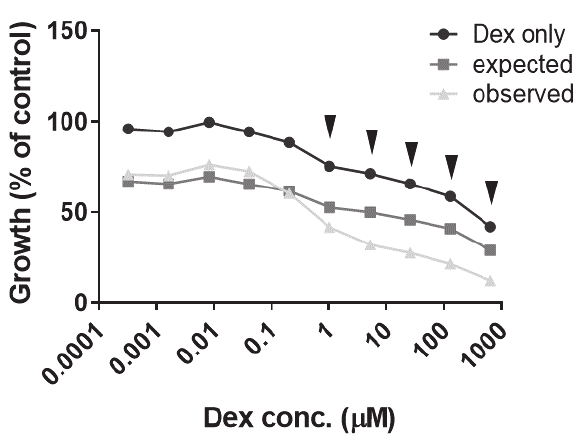
Figure A4. Dose–response curves obtained for CEM / R30dm after 72h incubation with 1 nM Plad-B combined with a dilution range of Dex. The expected e ff ect was calculated (by multiplying the e ff ects of both single agents alone) and plotted together with the dose–response curve to Dex alone and in combination with Plad-B. The arrows indicate points for which the observed response was greater than the expected response. Combination indexes (CI) calculated using Calcusyn are indicated above the arrows (mean CI = 0.276 ± 0.055). The panel depicts the mean of 3 independent experiments.